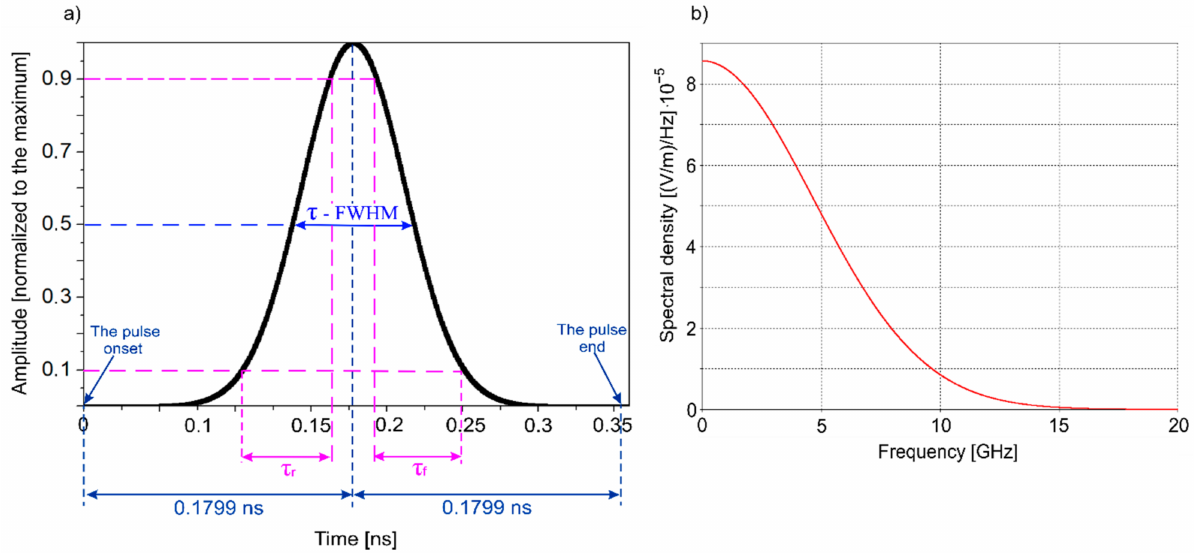
Figure 2. The normalized incident Gaussian EM plane wave pulse: ( a ) the time dependence of the electric field strength (or the magnetic field strength) and ( b ) the spectral density of the electric field strength of the incident Gaussian EM plane wave